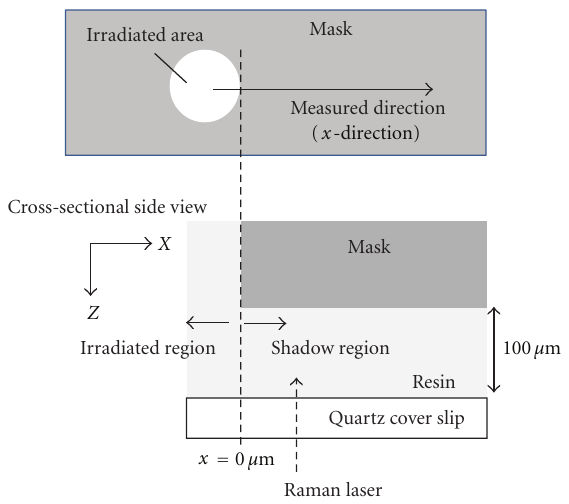
Figure 2: Schematic of the experimental geometry for the shadow cure studies. The mask was a 500 µ m thick steel plate with a 6 mm diameter hole through which the monomer mixture was illuminat- ed from above. After illumination of the prescribed duration, Raman microscopy was used to collect line ( x -direction) and depth ( z -direction) conversion profiles through the quartz cover slip on the bottom of the sample.